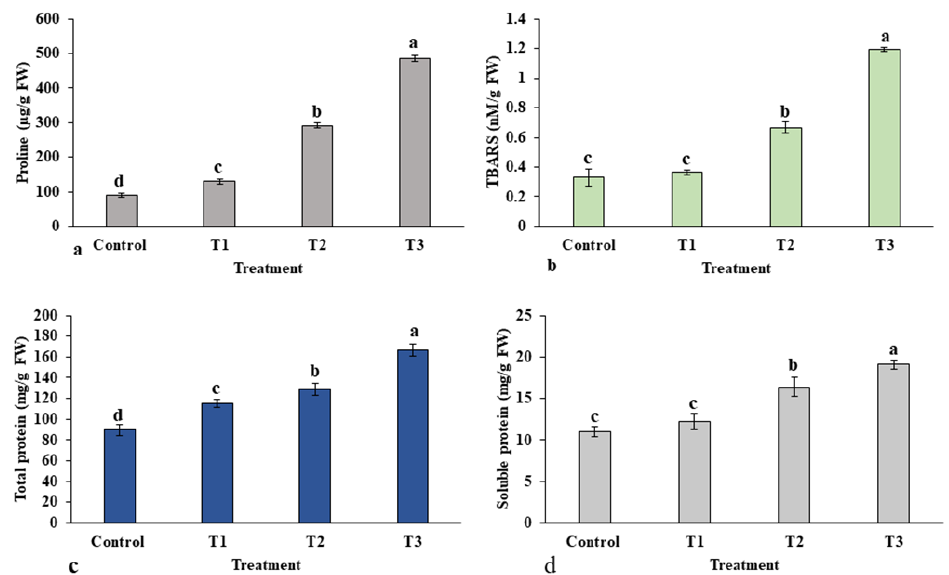
Figure 9. Effect of ZnO-NPs on accumulation of various biochemicals in the leaves of E. macrochaetus : ( a ) proline content; ( b ) TBARS content; ( c ) total protein content; ( d ) soluble protein content. Treatments including control (0 mg/L ZnO-NPs); T1 (10 mg/L, ZnO-NPs); T2 (20 mg/L, ZnO-NPs) and T3 (40 mg/L, ZnO-NPs). Bars represented by different letters indicate significant values according to Duncan’s test ( p < 0.05).